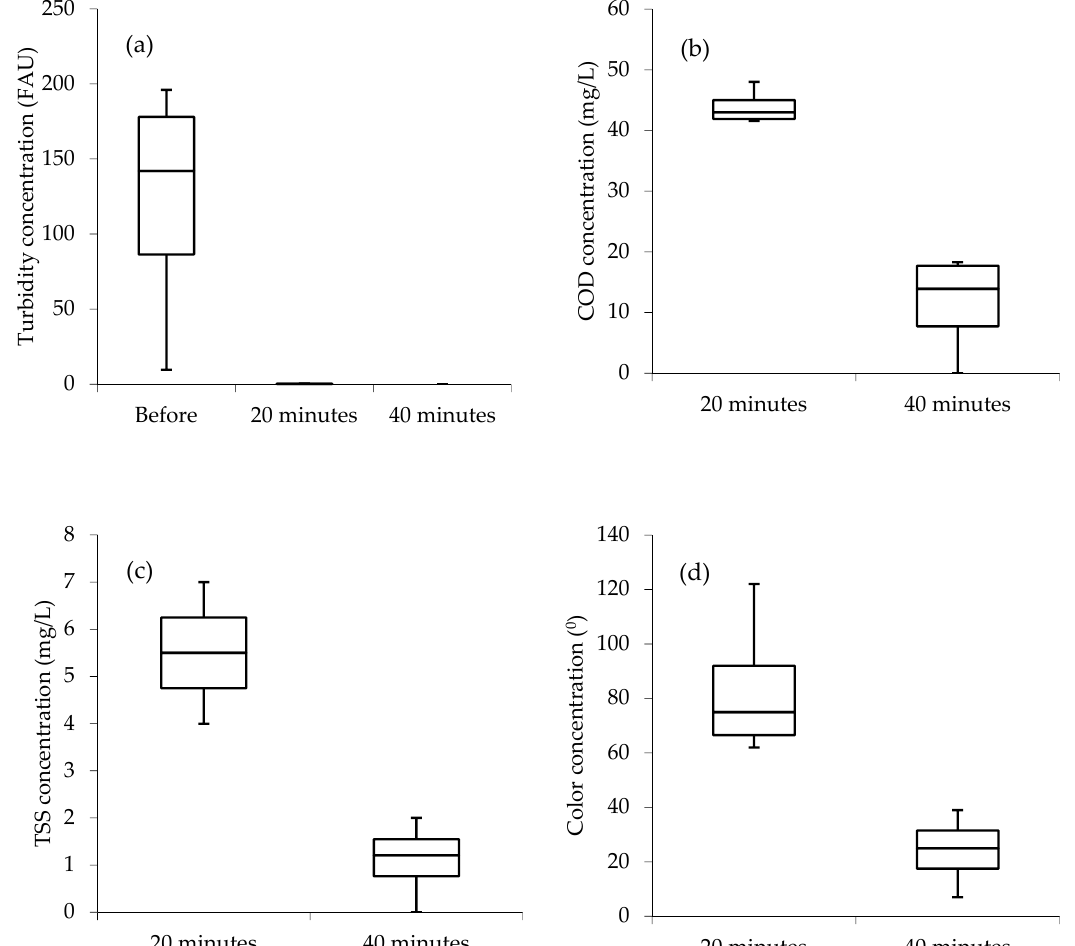
Figure 2. Boxplots (Al–Gr); ( a ) turbidity, ( b ) COD, ( c ) TSS, ( d ) color; Before = before treatment.